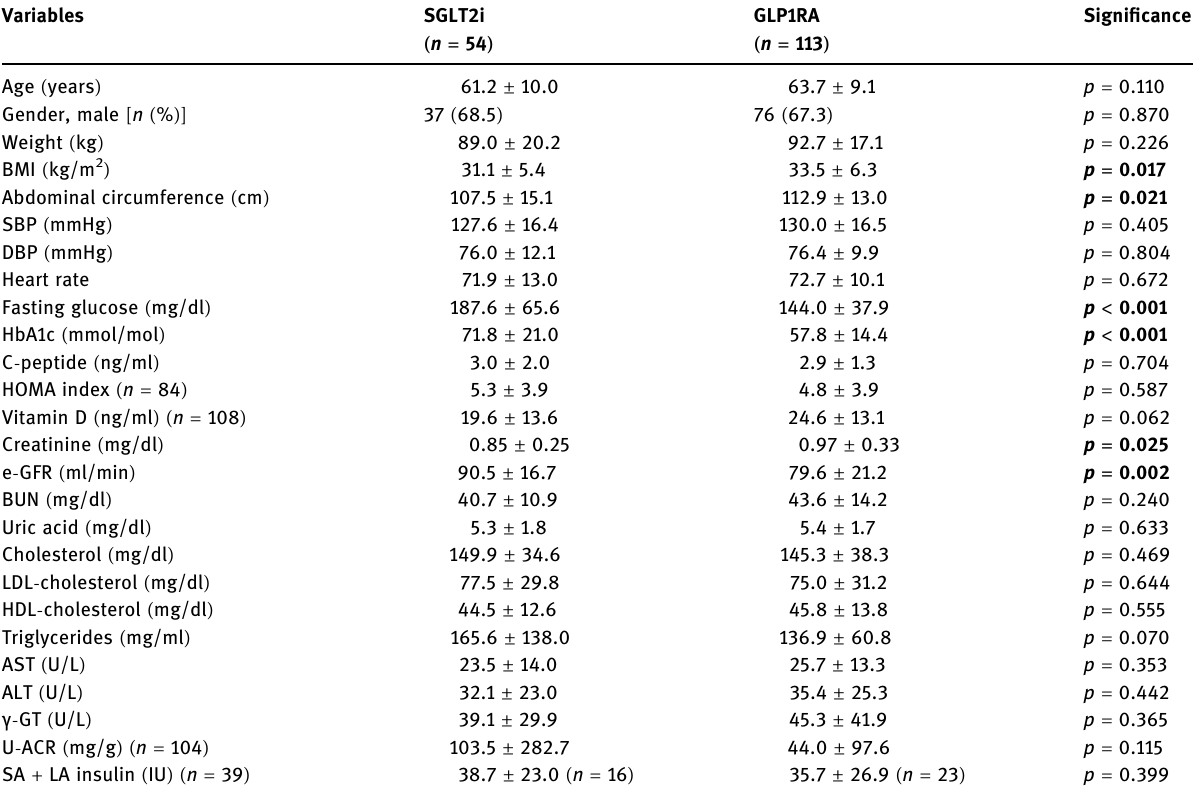
Table 2: Baseline characteristics of the study population divided according to the drug prescribed Variables